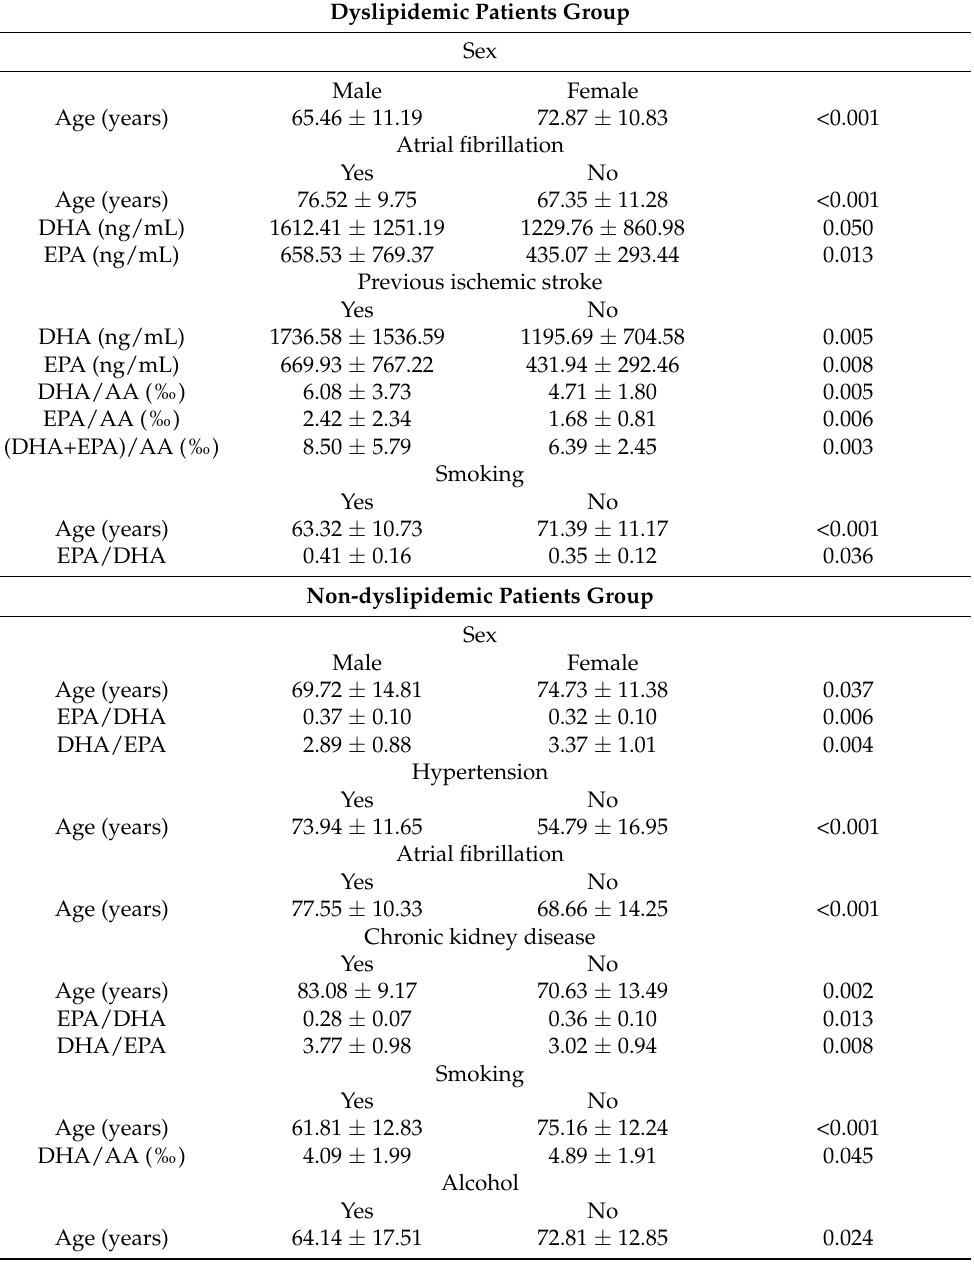
Table 7. Dyslipidemia groups ANOVA